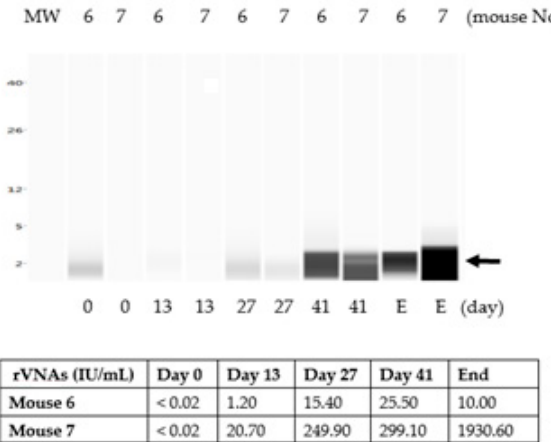
Figure 4. GnRH antibodies in mice immunized with ERA-2GnRH hydrogel. The GnRH antibodies were delayed and detected from day 41 through the termination of the experiment around day 70, which is suggestive of a slow, controlled vaccine release profile.